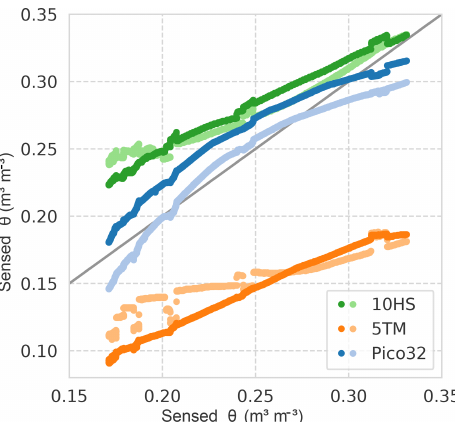
Figure 5. Soil water content in undisturbed monolith as laboratory reference. Gravimetric reference vs. sensor values of the three sys- tems (colours) with one replicate each (shading).